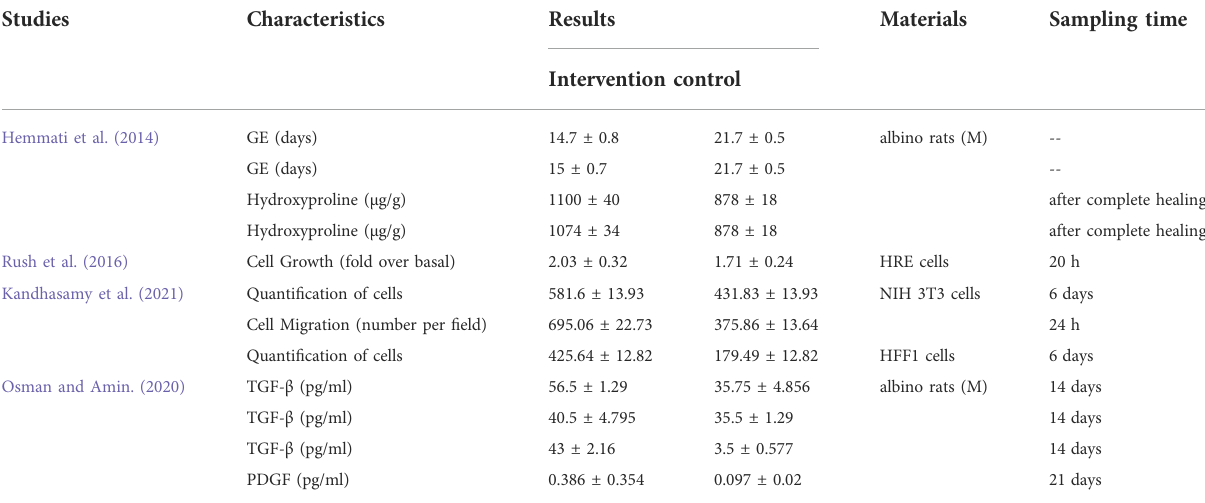
TABLE 4 Characteristics of Vitamin K for wound